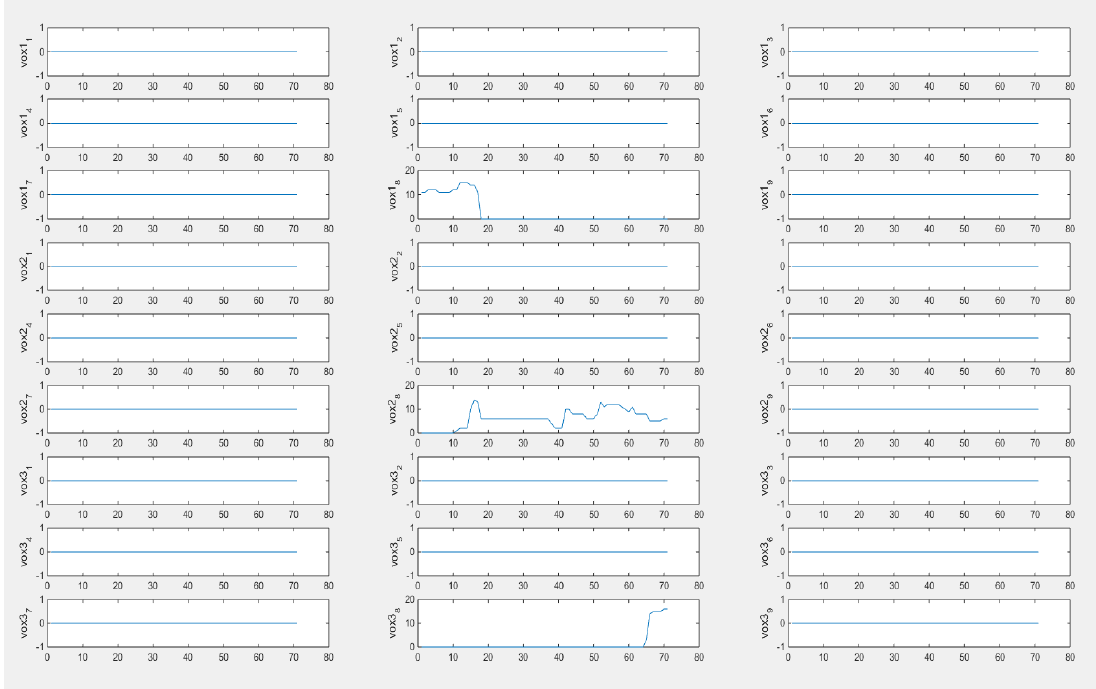
Figure 11. Plots of 27 voxels with thresholding data.